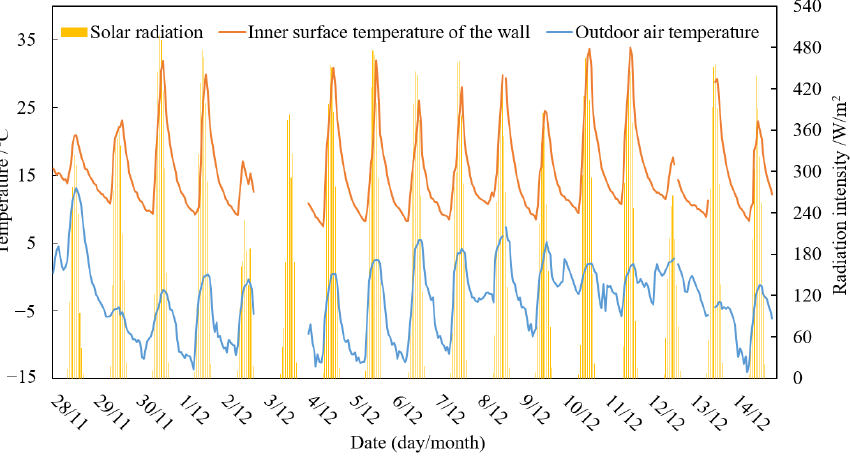
Figure 4. The temperature of the inner surface of the wall in the experimental solar greenhouse.